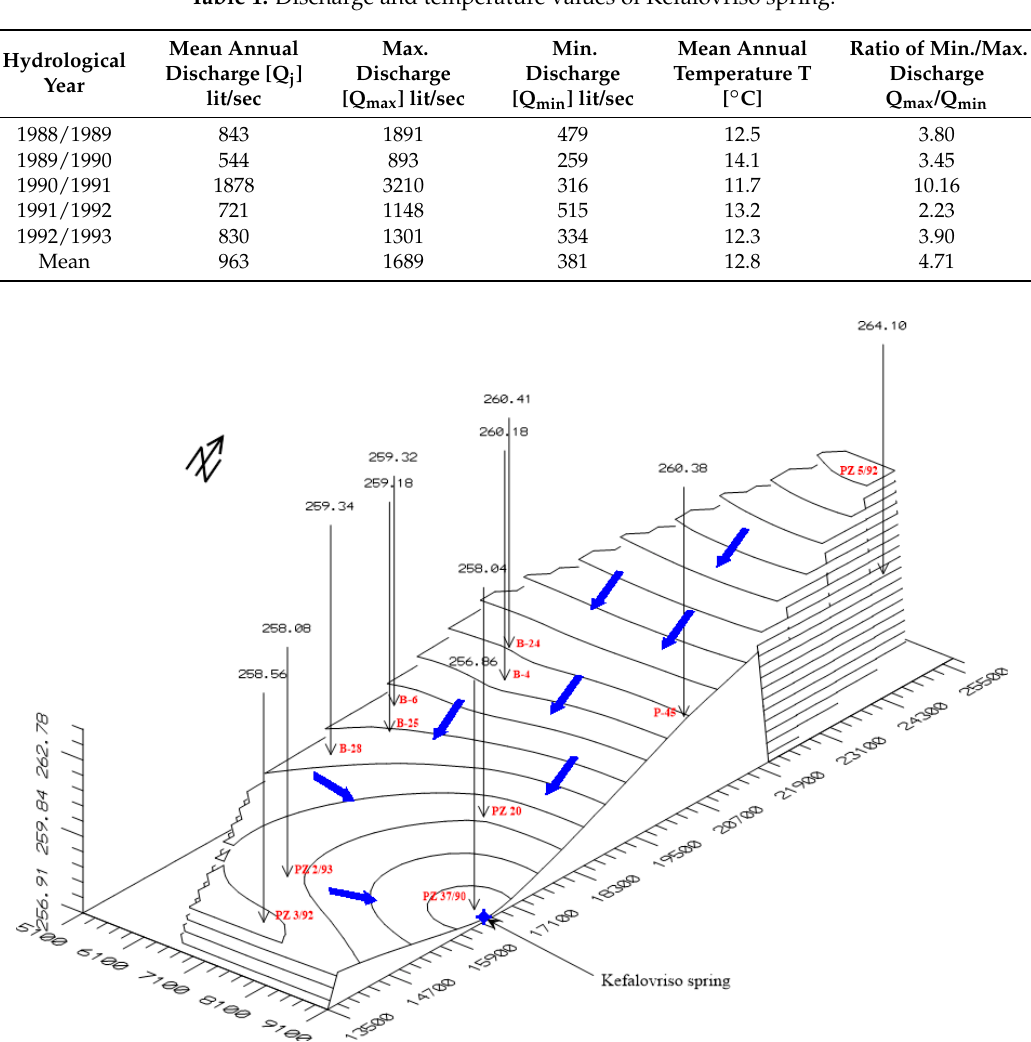
1000000 Figure 4. Monthly discharge of Deskatis River as measured at (1) before the karst aquifer (Deskatis bridge sampling point—in orange), (2) 1.5 km from Deskatis bridge and within the karst aquifer (Loutro sampling point—in yellow), and (3) 12 km from Deskatis bridge and within the karst aquifer (Valanidas sampling point – in green). 0200000 400000 600000 800000